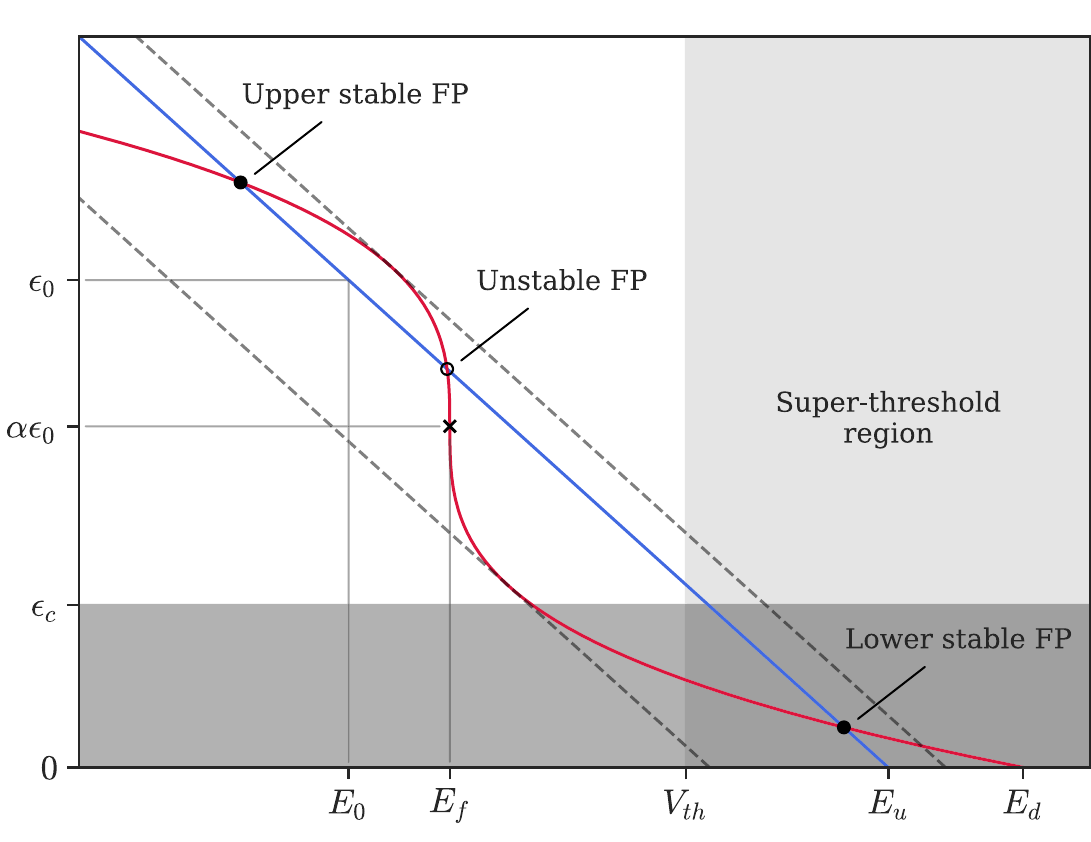
Fig 2. Phase space of the e LIF model in bistable parameter regime. V -nullcline is given by the blue line, � -nullcline by the red curve. Fixed points (FPs) are shown by the circles (filled for stable and empty for unstable) and the cross marks the inflection point of the � -nullcline. Dashed lines represent the shifts in the V -nullcline which lead to the disappearance of the unstable fixed point and of one of the stable fixed points (saddle-node bifurcation via the external current I e ). The super-threshold region, where spikes are elicited upon entrance, is marked by the light grey shading; the energy-limiting region ( � < � ) is marked by the grey shading and overlaps with the super-threshold region in the dark grey c area, where energy limitations prevent spiking though the neuron is above